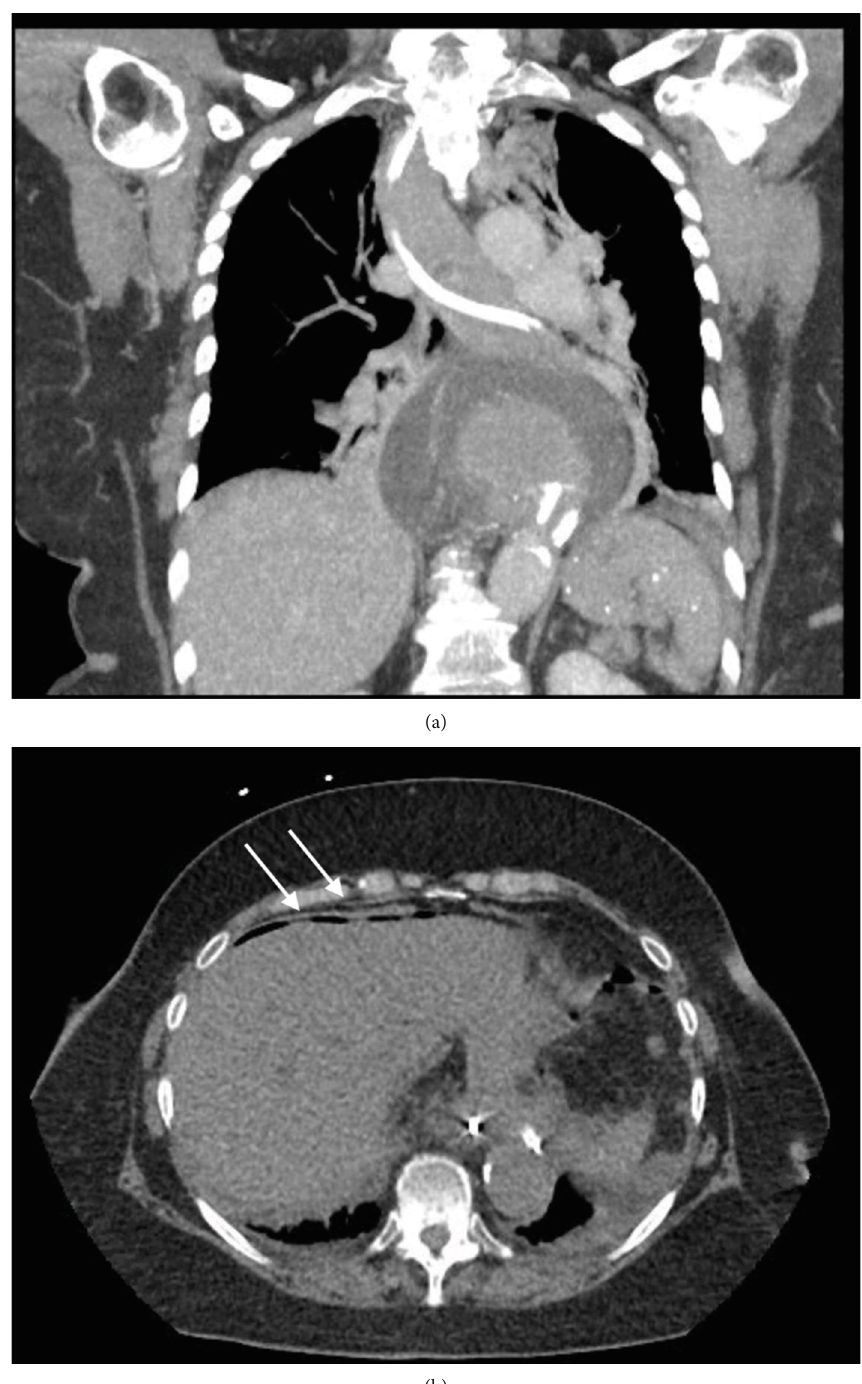
Figure 1: CT scan showing intra-abdominal and mediastinal free air and extraluminal contrast from the patient ’ s gastric perforation. (a) Coronal view. (b) Axial